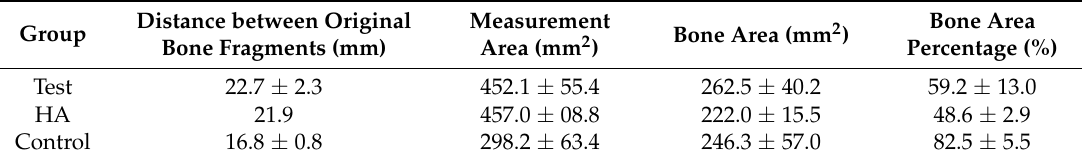
Figure 5. Toluidine blue staining of the former tibial bone defect area: ( a , d ) test group; ( b , e ) control group; ( c ) HA-group. Table 1. Histomorphometric analysis of the newly formed bone area (bone defect area) in between the original bone